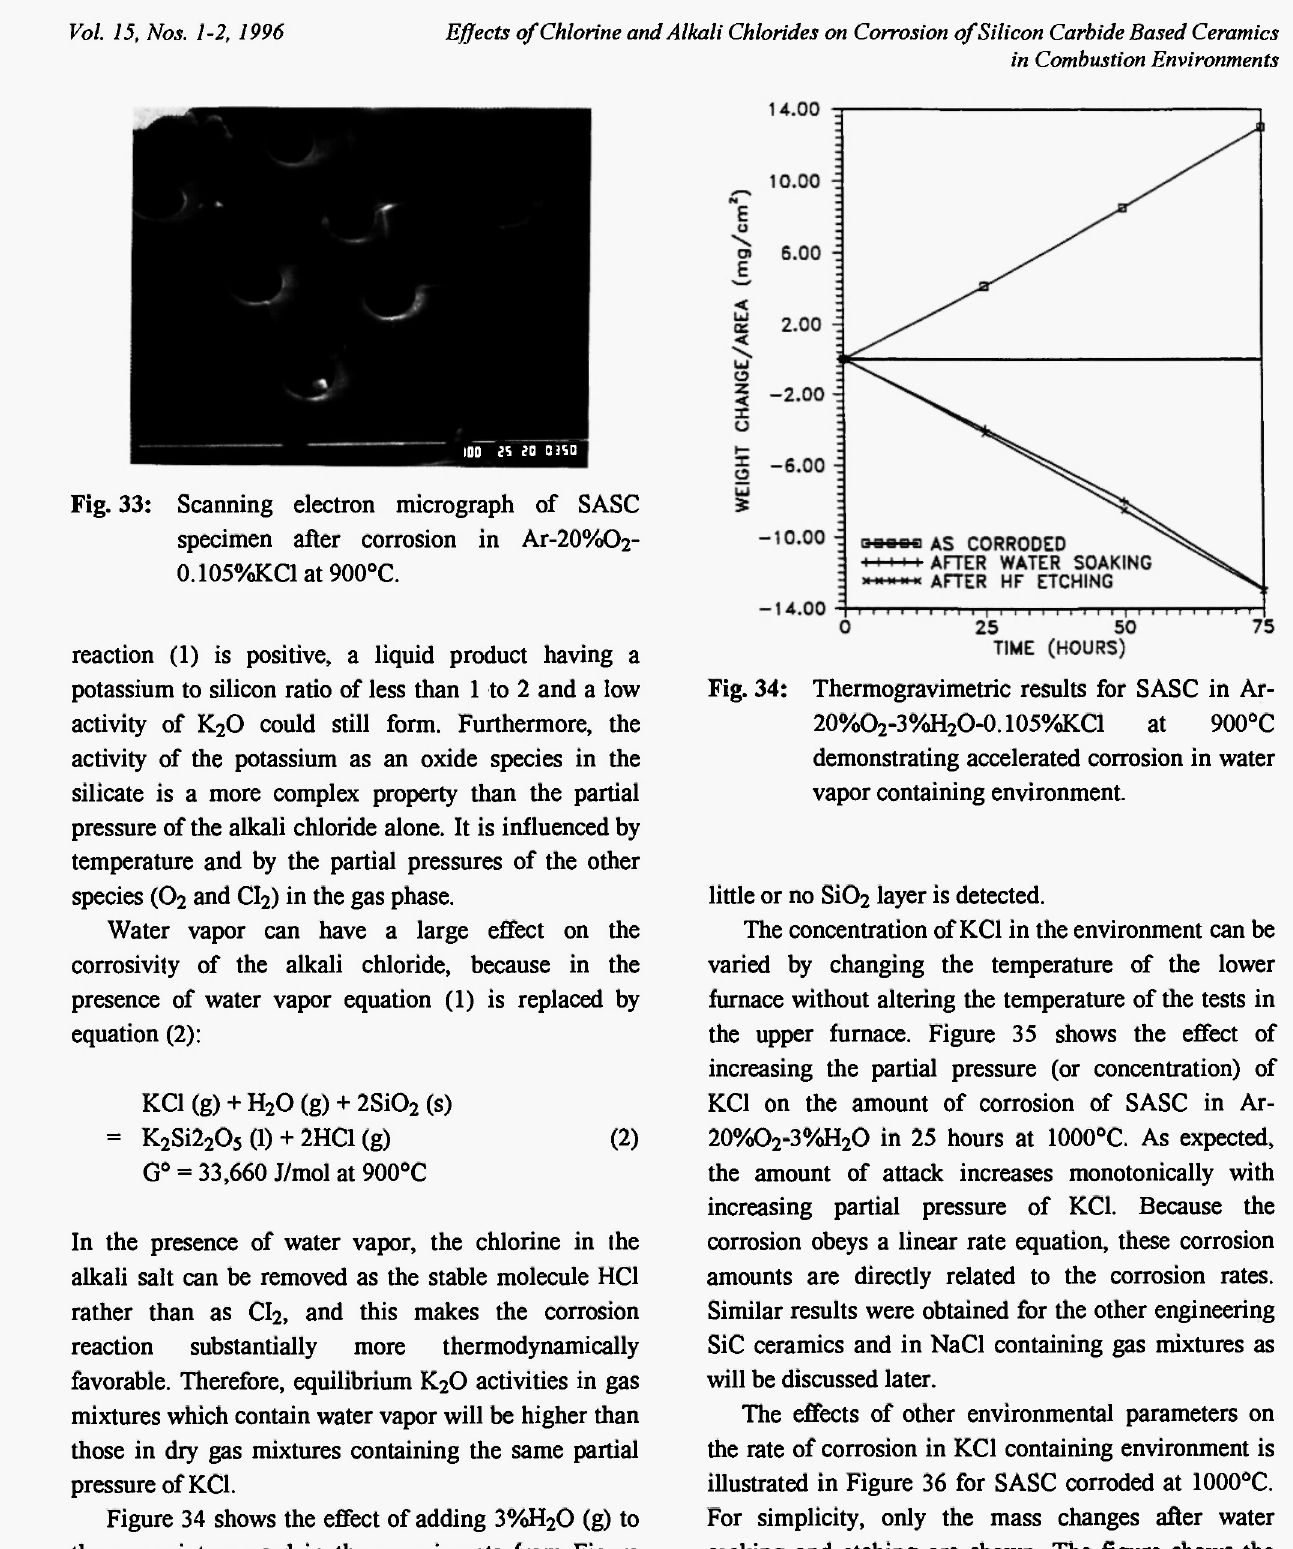
Fig. 33: Scanning electron micrograph of SASC specimen after corrosion in Ar-20%02- 0.105%KC1 at 900°C.